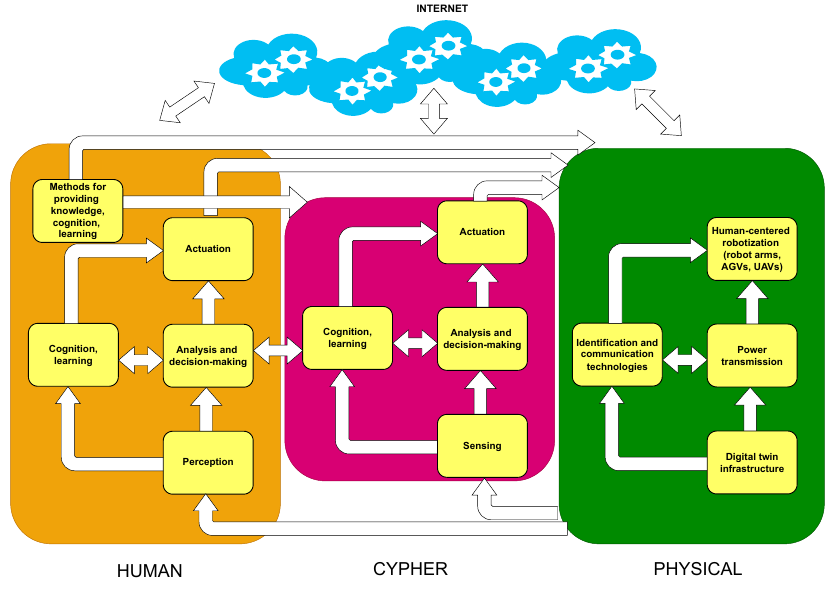
Figure 2. Main aspects of